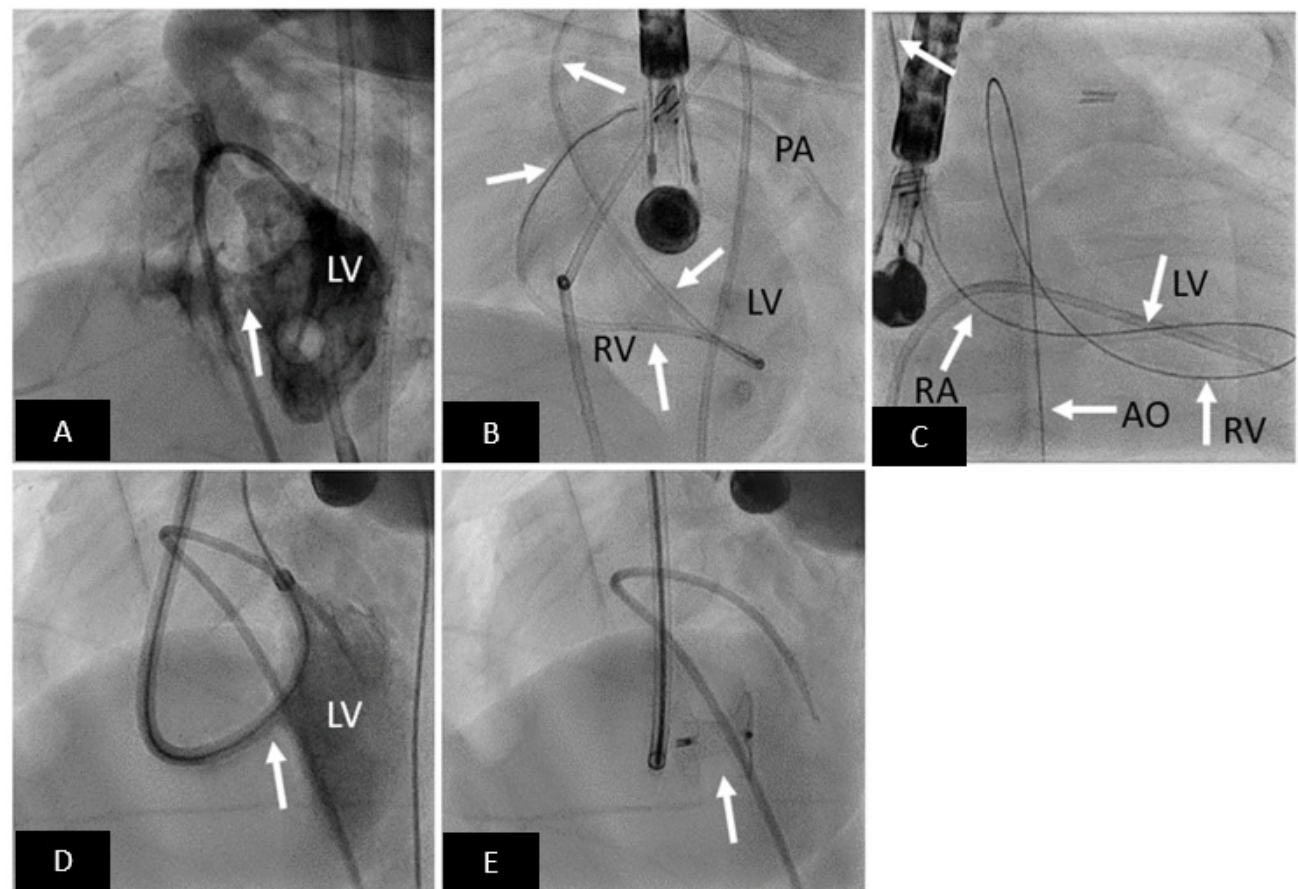
Figure 3. Transcatheter mVSD closure with Amplatzer Muscular VSD Occluder. ( A ) LV angiogram in cranially angulated left anterior oblique projection showing muscular VSD (arrow). ( B ) Catheter is advanced from aorta to LV, and then across the VSD into the RV, and then into the pulmonary artery. ( C ) An arteriovenous loop is created; right internal jugular-RA-RV-LV-AO-femoral artery. ( D ) Delivery sheath advanced from RIJ across the VSD (arrow) into the LV over the AV loop created. ( E ) Well positioned mVSD occluder (arrow) after release. LV = left ventricle, RV = right ventricle, PA = pulmonary artery, RA = right atrium, AO = aorta.